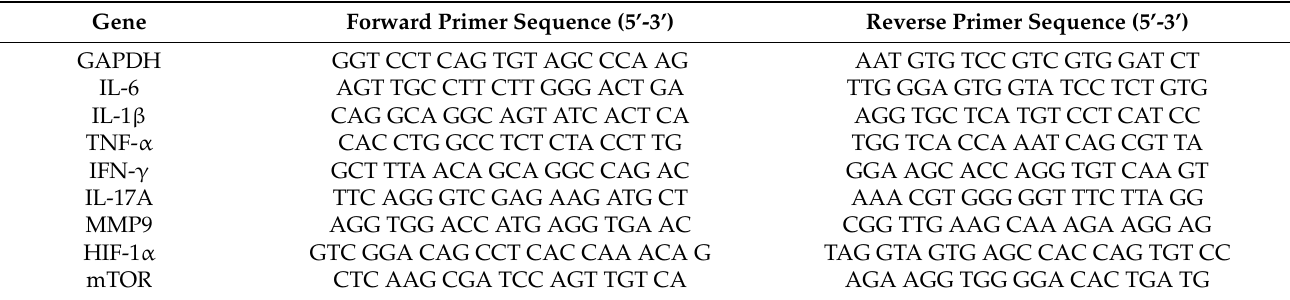
Table 1. Sequence list of primers used in real-time